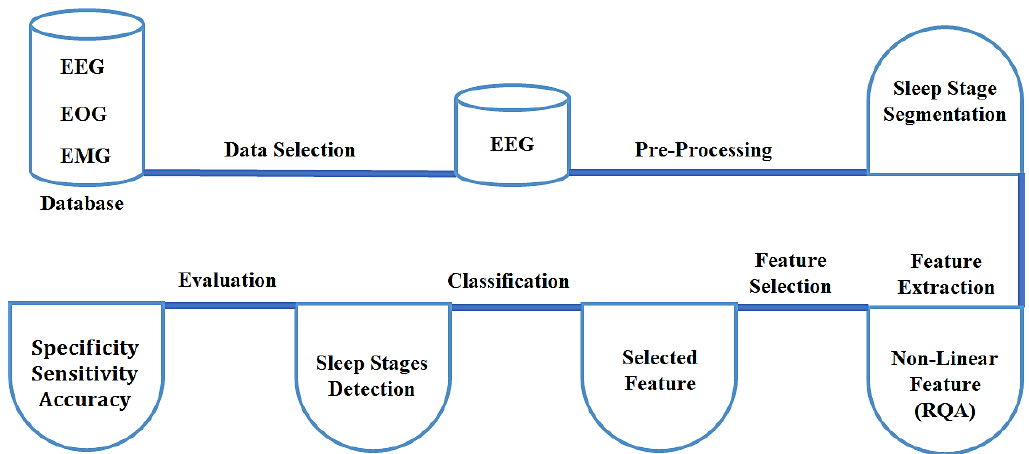
Fig. 2. Sleep stage classification system block